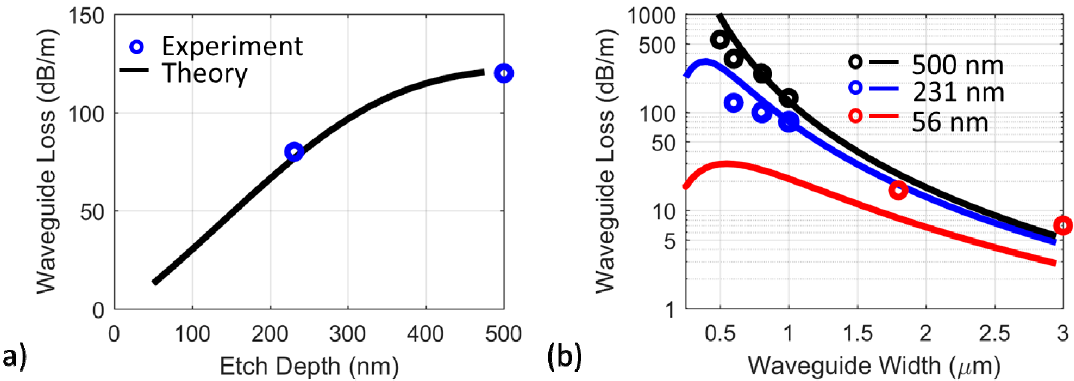
Figure 3. ( a ) Experimental data (circular markers) and theoretical curve (solid line) for the propagation loss of 1 µm wide waveguide at varying etch depth. ( b ) Theoretical calculations (solid lines) of the waveguide loss at varying waveguide width at three different etch depth (500 nm, 231 nm and 56 nm). The experimentally measured results are plotted in circular markers.